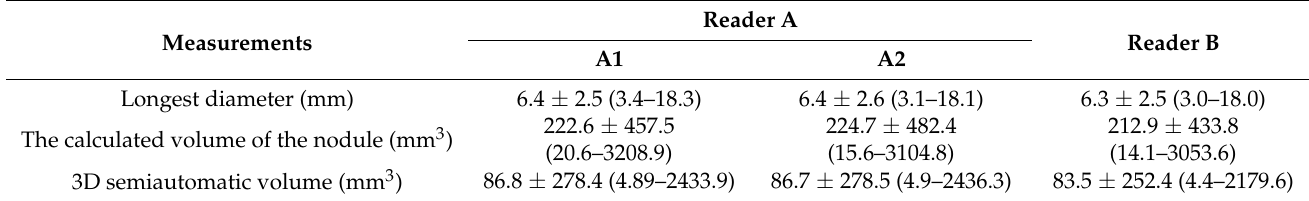
Table 1. Descriptive statistics of the data obtained by the two